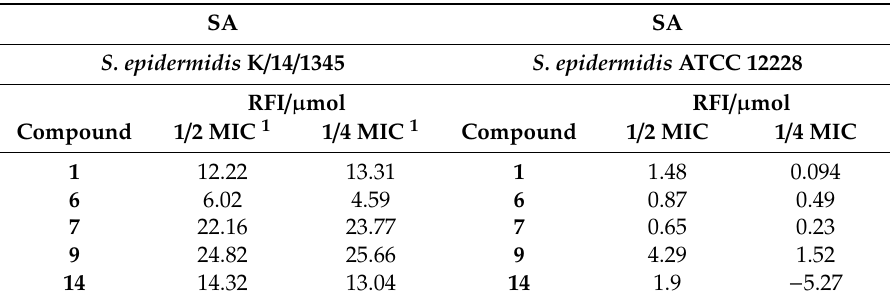
Table 4. Specific activity (SA) of active 5,5-dimethylhydantoin derivatives tested at the concentration corresponding to 1 / 2 and 1 / 4 of their MIC values on the accumulation of EtBr in S. epidermidis strain K / 14 / 1345 and ATCC